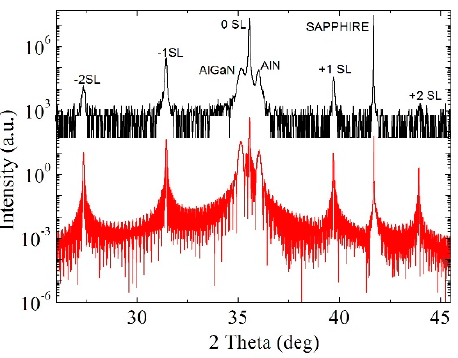
Figure 3. A long range 2 θ - ω scan of (0002) reflection for AlN/Al x Ga 1 − x N (0.07 < x < 0.09) obtained using a hybrid X-ray mirror. Black line—data [61], red line—simulations (courtesy of Dr. A. Chandolu).